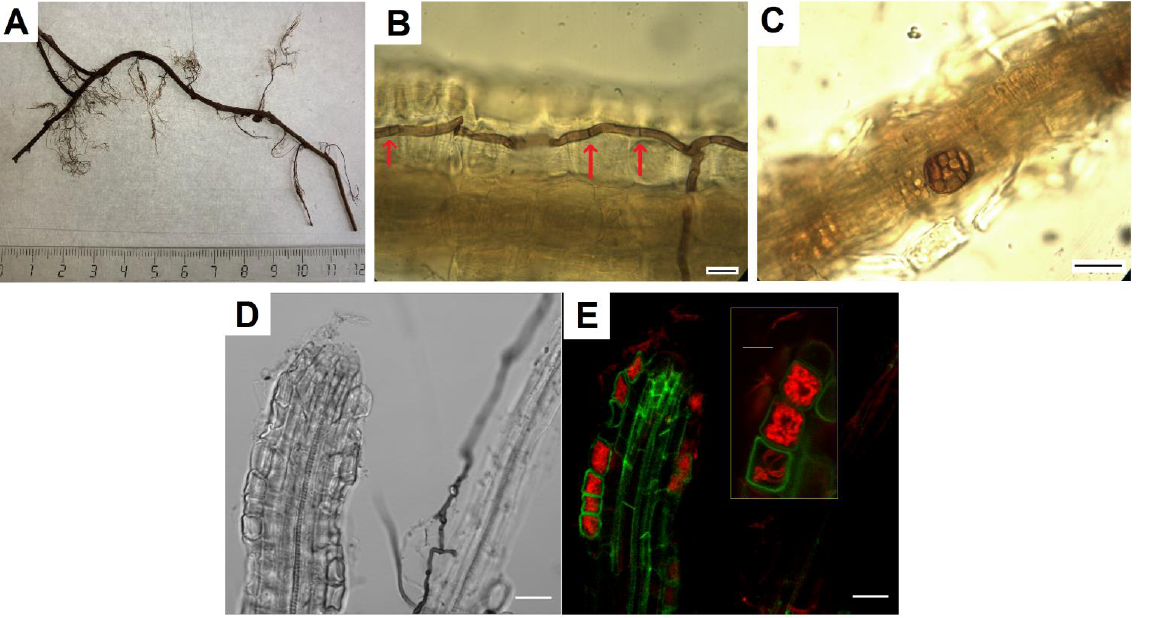
Figure 1. Mycobiome of V. vitis-idaea roots: ( A ) fragment of V. vitis-idaea root, from which fungi were isolated; ( B ) DSE melanized hyphae in V. vitis-idaea root, stained with trypan blue. Arrows indicate septa; ( C ) DSE microsclerotia in root; ( D ) transmitted light image of V. vitis-idaea root; ( E ) CLSM image of V. vitis-idaea root, stained with trypan blue. Autofluorescence of root cells (green signal) obtained at λ ex = 488 nm, λ em = 499–540 nm; fluorescence of fungal hyphae stained with trypan blue (red signal) obtained at λex = 594 nm, λem = 620 – 700 nm. Bar = 10 µm. The isolation of slow-growing fungi obtained from 60 fragments of V. vitis-idaea roots using a PDA nutrient medium allowed us to obtain 57 fungal isolates. In the group of slow-growing isolates, however, differences in colony morphology and growth rate were observed, and the latter varied from 1.6 to 3 mm/day. Isolates showing similar morphologies and growth rates were grouped into seven morphotypes; isolates with a dark coloration of colonies and septated hyphae were assigned to morphotypes DSE1, DSE2, DSE3, DSE4, and DSE5 (Supplementary Table S1), while isolates with a light col- oration of colonies and non-septated hyphae were assigned to Non-DSE1 and Non-DSE2. Non-DSE1 colonies were initially white and then they turn light gray; Non-DSE2 colonies were pink. Colonies of DSE1 – DSE5 morphotypes were dark, but differed in growth rate, color, and surface texture. The colors of these colonies varied from dark brown to brown-green, and colonies differed in degree of aerial mycelium development. Sporulation was not observed in any of these colonies. According to the morphological characteristics and on the basis of comparison of their ITS sequences with sequences in GenBank, DSE1, DSE2, and DSE3 morphotypes were identified as Phialocephala fortinii Wang, Wilcox, whereas the DSE4 morphotype was identified as Acephala applanata Grünig, Sieber, i.e., all of them were PAC species. The DSE5 morphotype was identified as not belonging to PAC P. bamuru Wong, Dong (Sup- plementary Table S1). The DSE2 isolate, which showed maximal similarity (100%) of ITS sequences with P. fortinii , including the Y1A strain isolated from V. vitis-idaea (sequences ID: KJ817297.1 GenBank), was used in further experiments. It was characterized by its dark-brown-colored mycelium, velvety surface with poorly developed aerial mycelium, and absence of exudate (Figure 2).